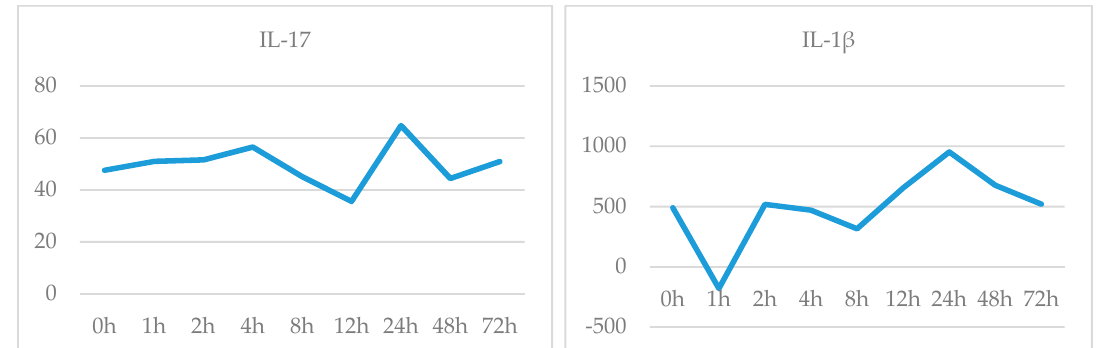
Figure 3. LL-37 (ng/mL) and TNF- α (ng/L) release-time graph.